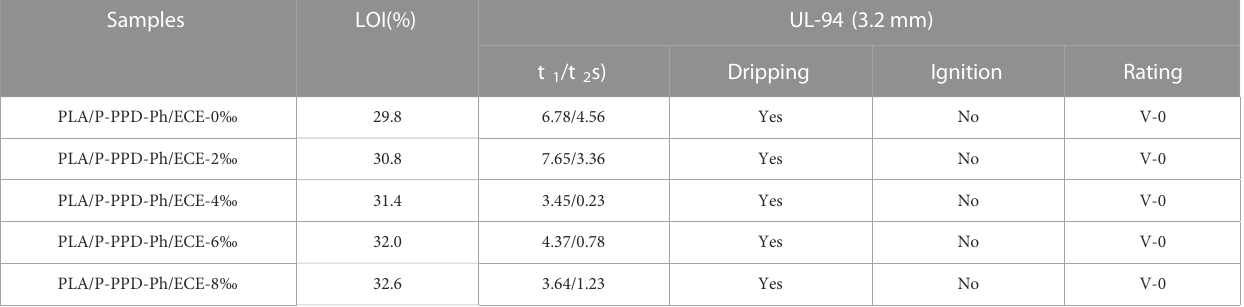
TABLE 2 Test results of UL-94 and LOI.